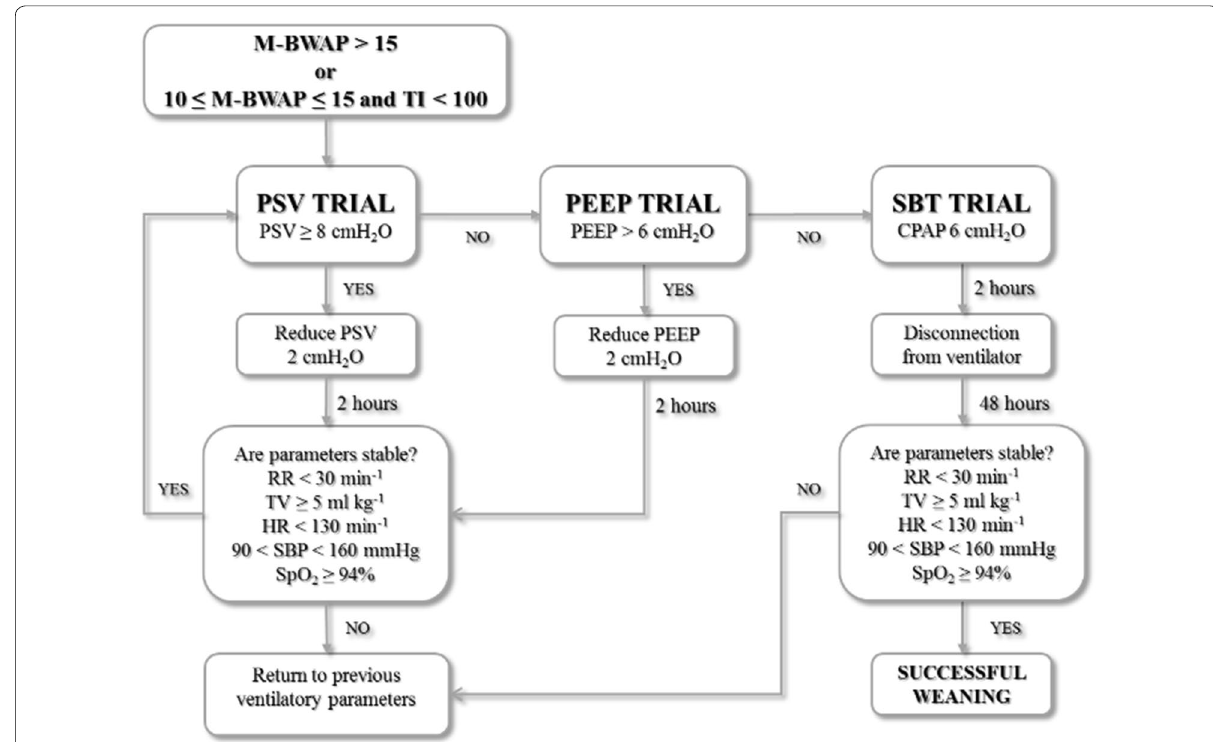
Fig. 1 The nurse-led weaning protocol for tracheostomized critically ill patients. The figure shows the pressure support ventilation (PSV) trial, posi- tive end-expiratory pressure (PEEP) trial and spontaneous breathing trial (SBT). CPAP continuous positive airway pressure, HR heart rate,